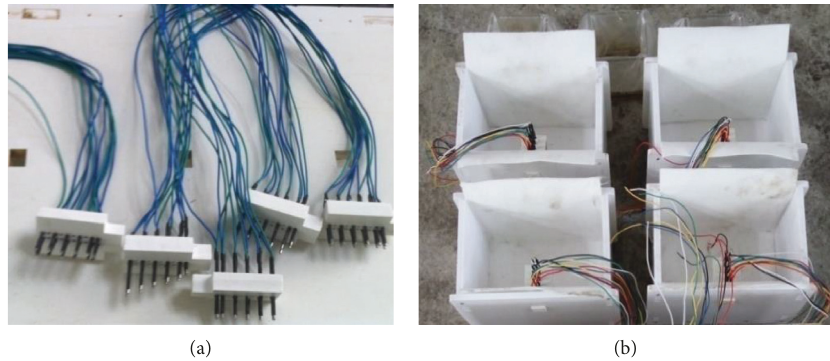
Figure 3: Electrical probes and their